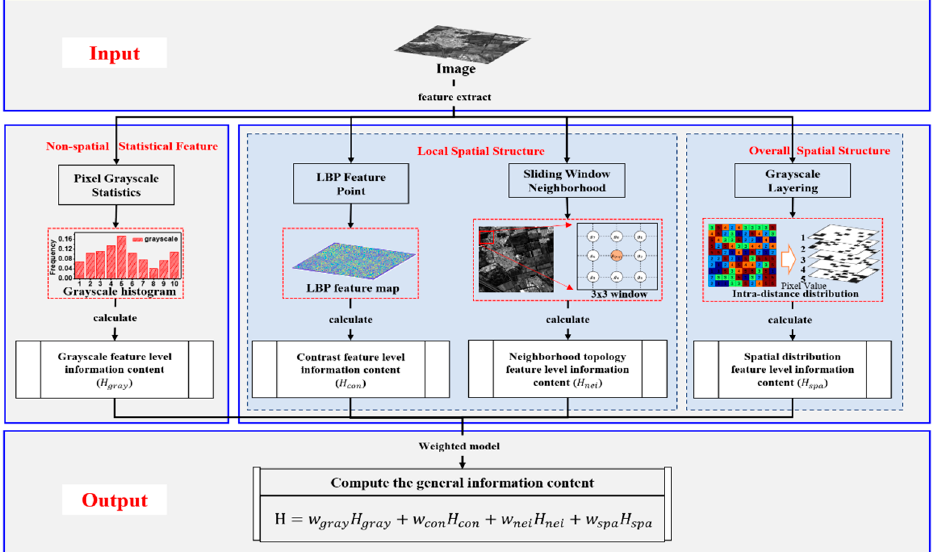
Figure 1. Flow chart for the multi-feature framework for quantifying information content of an op- tical remote sensing imagery. optical remote sensing